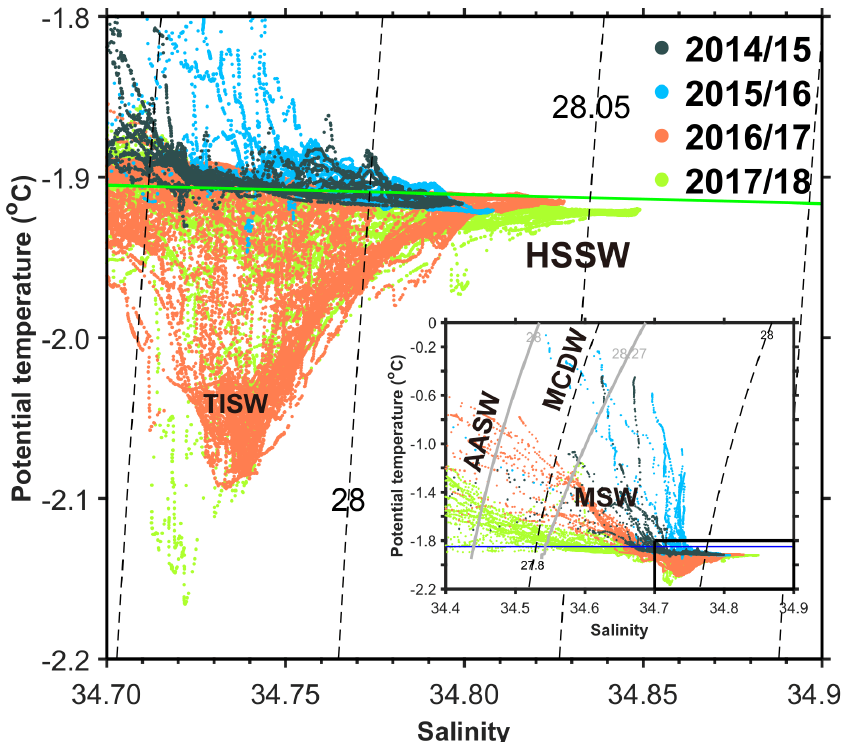
Figure 6. A zoomed-in plot of the θ – S diagram for CTD data collected in TNB during each observation period. The solid green line denotes the freezing point at the surface depending on the salinity, and the black dashed lines indicate isopycnals. The full-range θ – S diagram is shown in the inset. The black box and blue line in the inset indicate the ranges of the magnified plot and the − 1 . 85 ◦ C isotherm, respectively. The gray solid lines denote 28 and 28.27kgm − 3 neutral density ( γ n ) surfaces. AASW, MCDW, MSW, TISW, and HSSW represent Antarctic Surface Water, modified Circumpolar Deep Water, modified shelf water, Terra Nova Bay ice shelf water, and high-salinity shelf water,